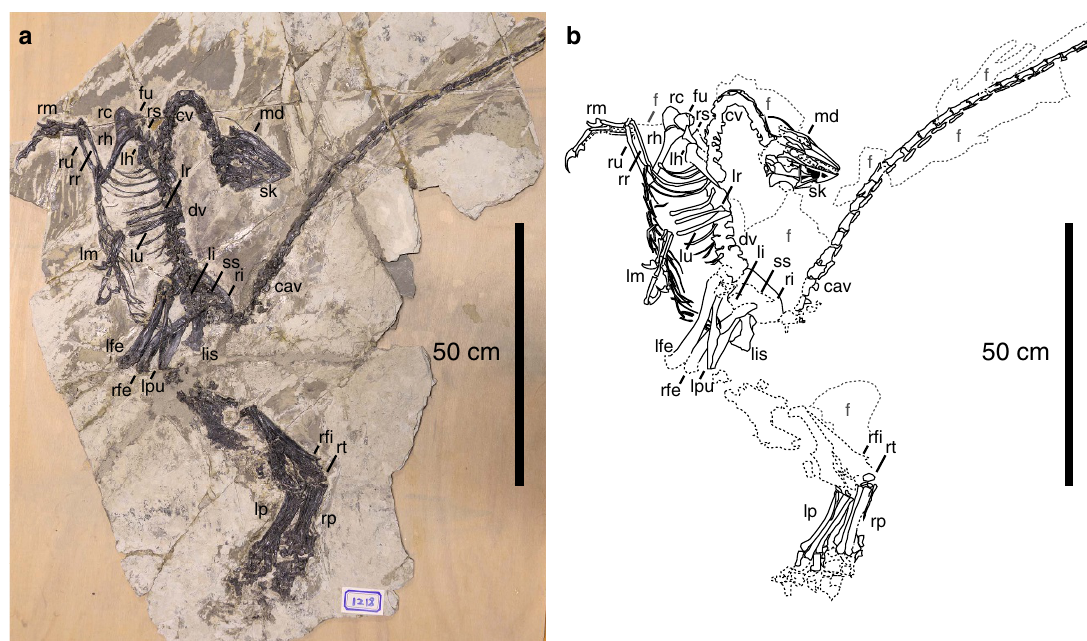
Figure 1 | Jianianhualong tengi holotype DLXH 1218. ( a ) Photograph and ( b ) line drawing of the specimen. Scale bar, 50cm. cav, caudal vertebrae; cv, cervical vertebrae; dv, dorsal vertebrae; fu, furcula; lfe, left femur; lh, left humerus; li, left ilium; lis, left ischium; lm, left manus; lp left pes; lpu, left pubis; lr, left radius; lu, left ulna; md, mandible; rc, right coracoid; rfe, right femur; rfi, right fibula; rh, right humerus; ri, right ilium; rm, right manus; rr, right radius; rs, right scapula; rt, right tibiotarsus; ru, right ulna; sk, skull; ss,